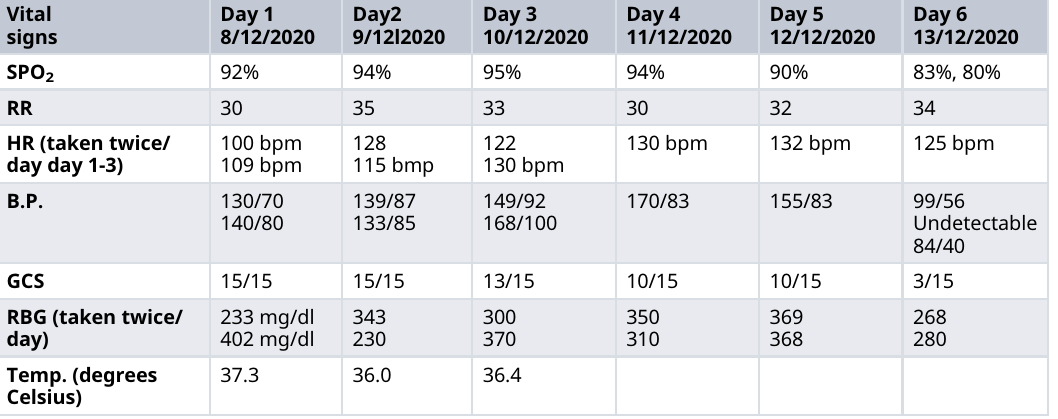
Table 2. Daily vital signs of the patient (Case 1). Vital